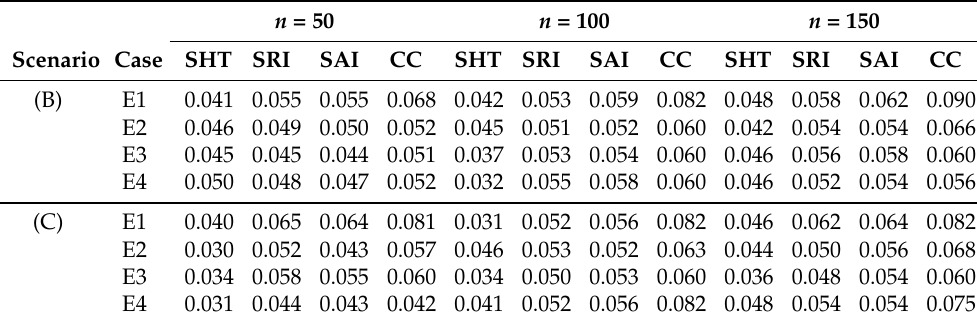
Table A1. Empirical Type I error rates for Scenarios (B) and (C) with balanced designs.